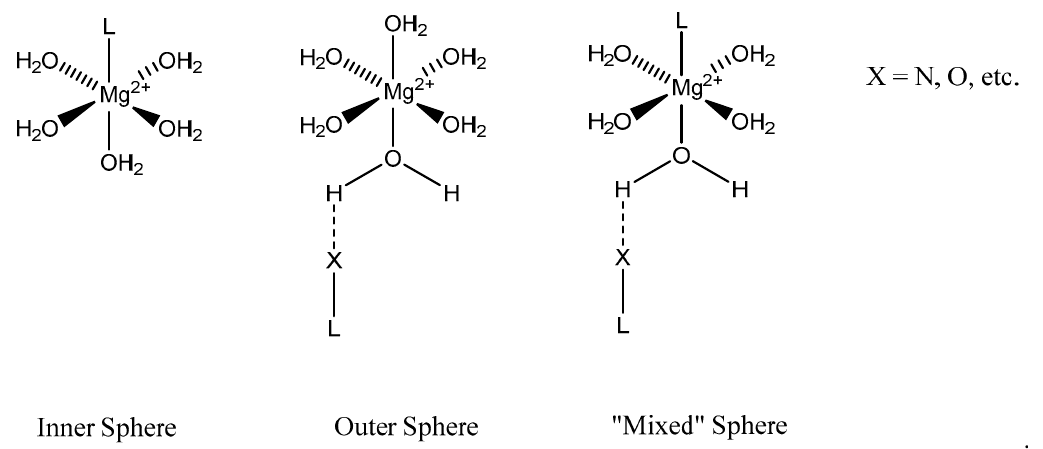
Figure 2. Illustration of the different ligand coordination modes utilized by magnesium. Adapted from Weston [40].